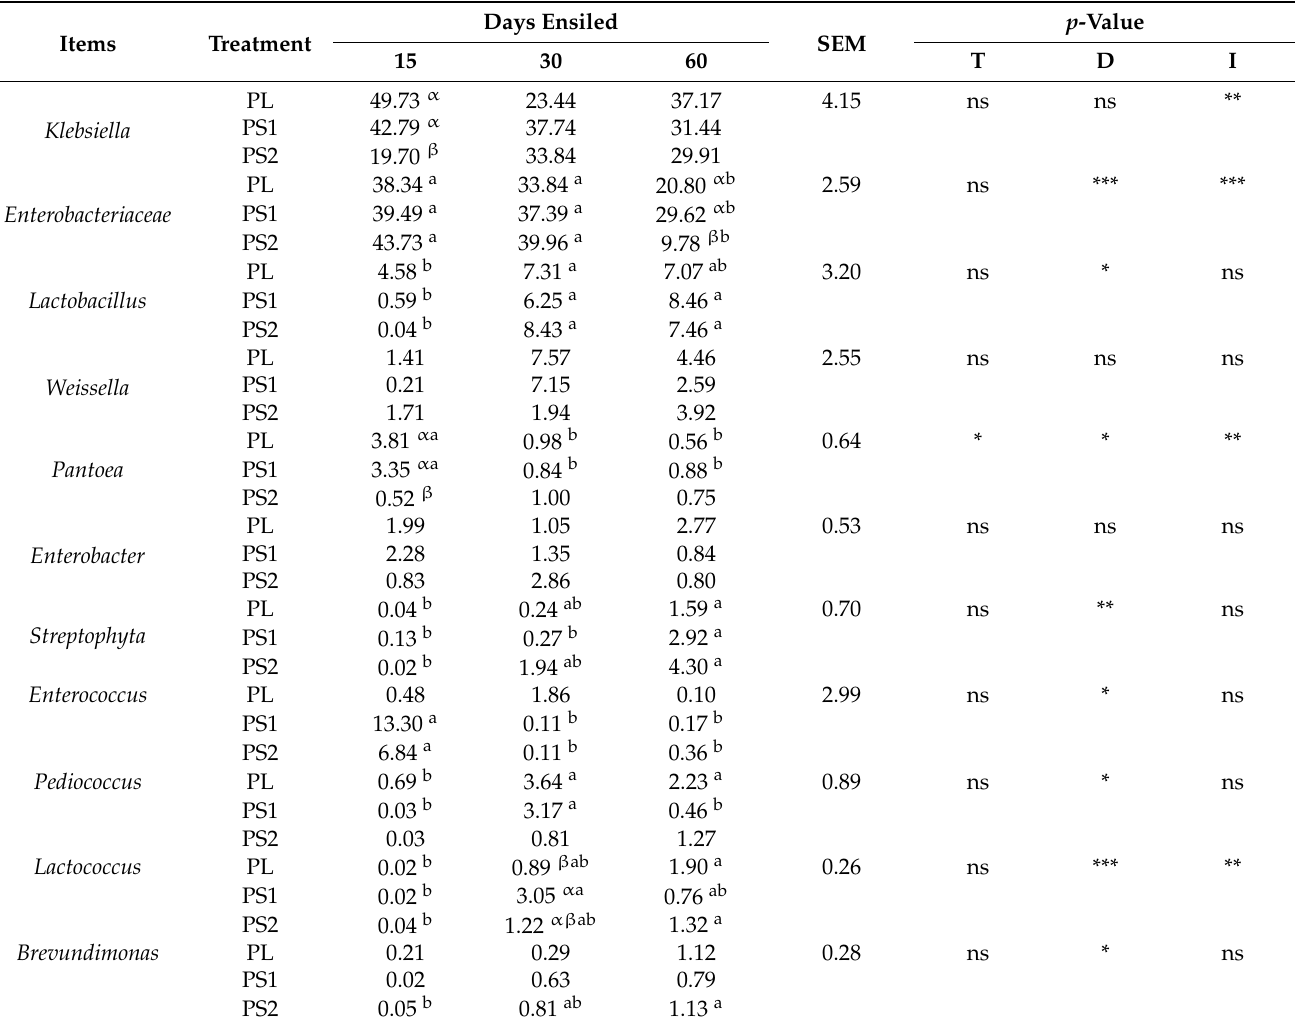
Table 6. Relative abundance of genera (%) present in kudzu